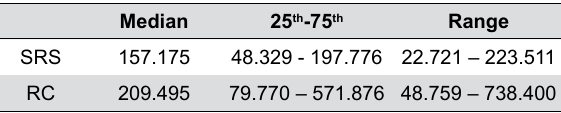
Table 1- Total numbers of DESeq normalized reads (median/ percentile/range) by